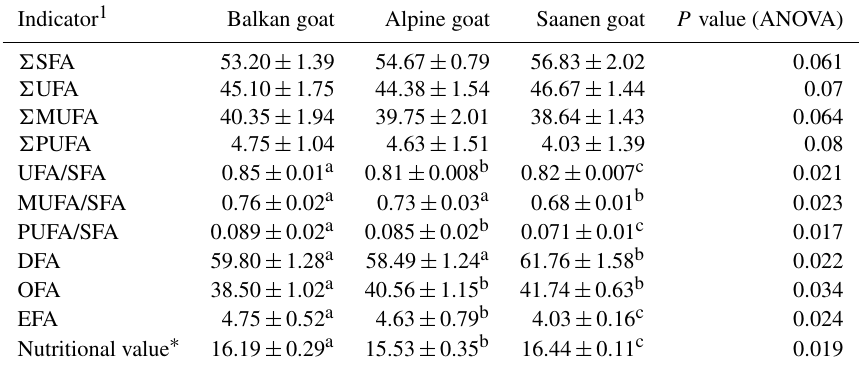
Table 3. Indicators of the nutritional value and health benefits of fat determined based on an analysis of the fatty acid profile of goat meat ( n = 40 per